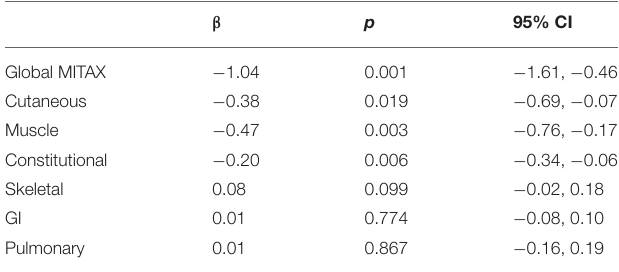
TABLE 2 | Association of capillary density measurements with individual and composite MITAX scores. β p 95%